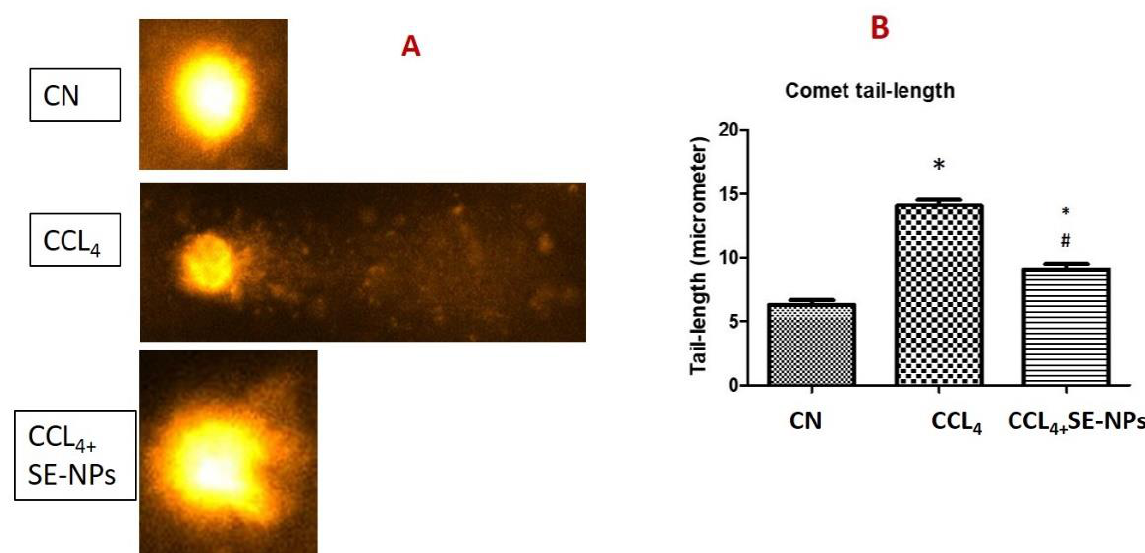
Figure 7. Representative photos ( A ) and data analysis ( B ) of the Comet tail length from different rat groups. * ( p -value < 0.05) indicates significant differences in different rat groups in comparison to control (CN) group animals. # ( p -value < 0.05) indicates significant differences in different rat groups in comparison to the CCl 4 group animals.